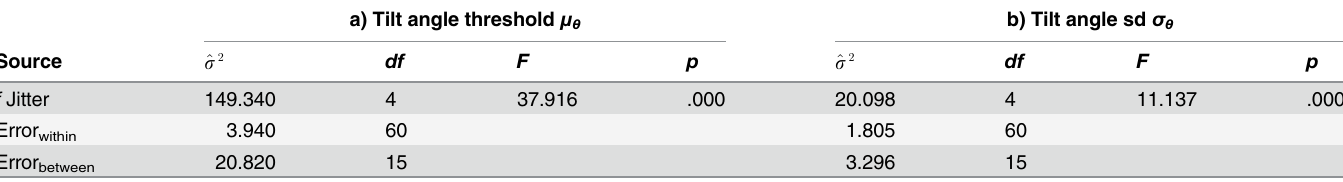
Table 1. rmANOVA results for tilt angle thresholds μ θ and tilt angle standard deviations σ θ .